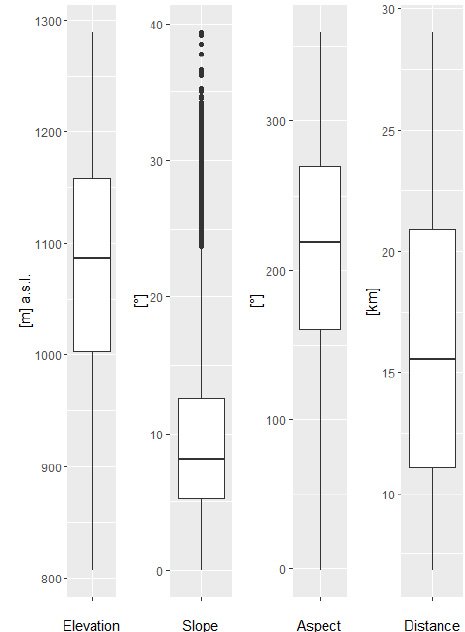
Figure 7. Topographic constraints of Tillandsia